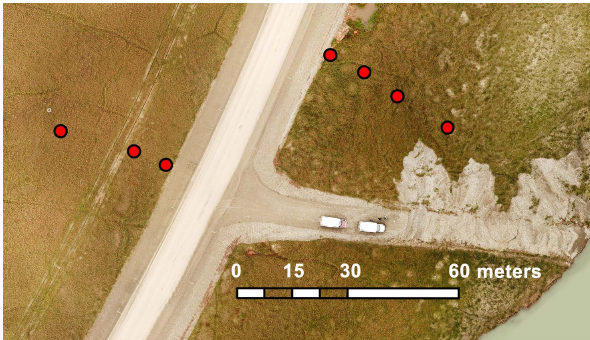
Figure A1. Transect of iButton soil temperature loggers across the Dalton highway at our site close to Deadhorse (70.099 ◦ N, 148.511 ◦ W). Red dots indicate the position of iButton sensors, the bright grey element shows the gravel road surface, the adjacent darker grey elements show the road shoulders. To the right a side road leading to the adjacent Sagavanirktok River (lower right) is seen (drone photo by Soraya